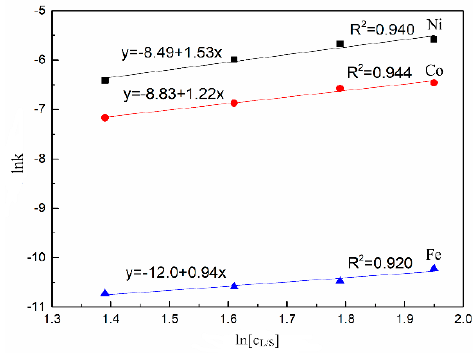
Figure 12. The ln k − ln c(NH 4 Cl) of Ni, Co, and Fe.